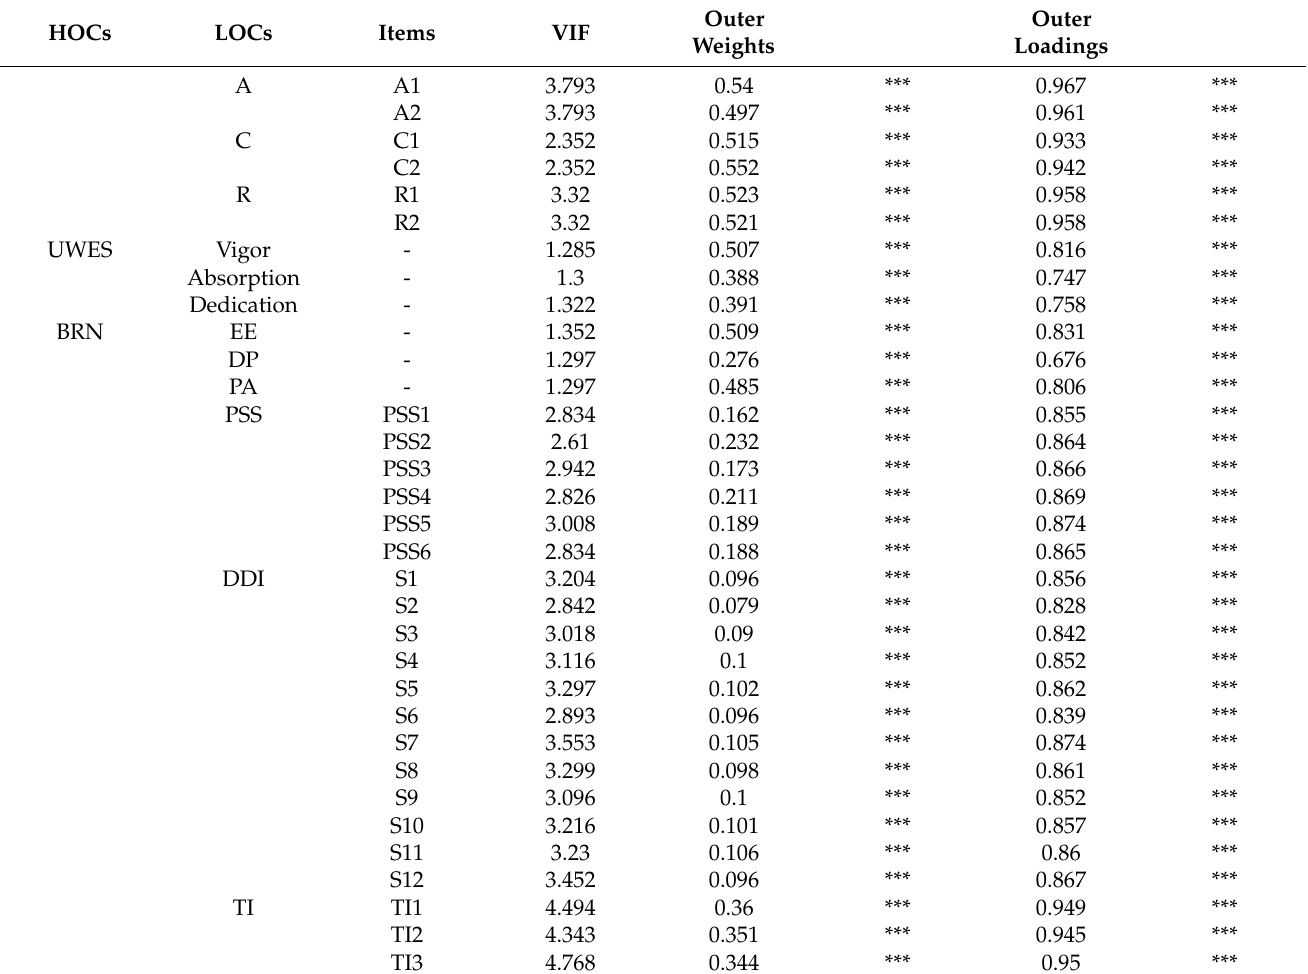
Table A6. Stage 2—Higher Order Constructs Validation: Multicollinearity Analysis, Outer Weights, and Outer